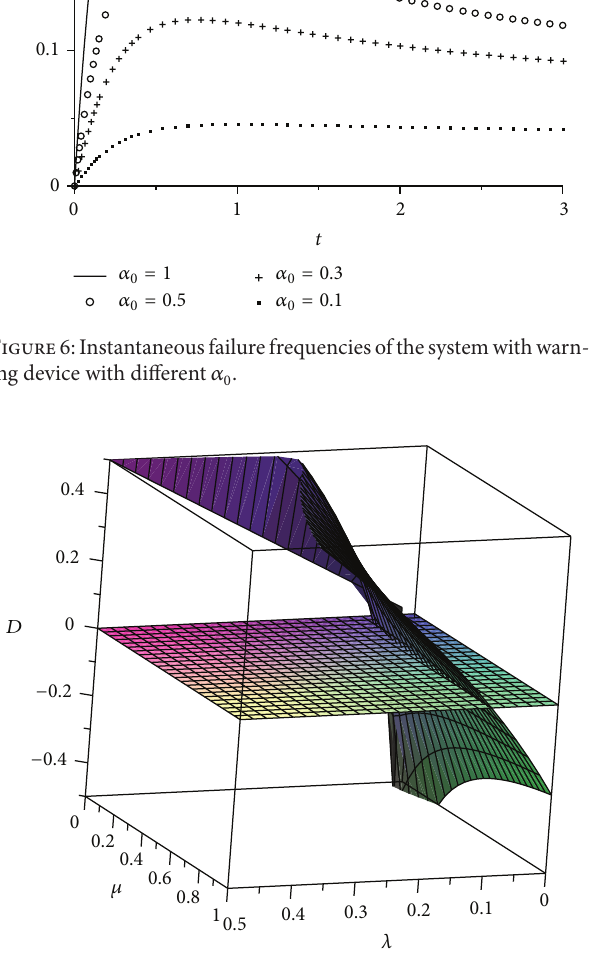
Figure 7: Profit difference of systems with and without warning device with 𝛼 0 = 0 .